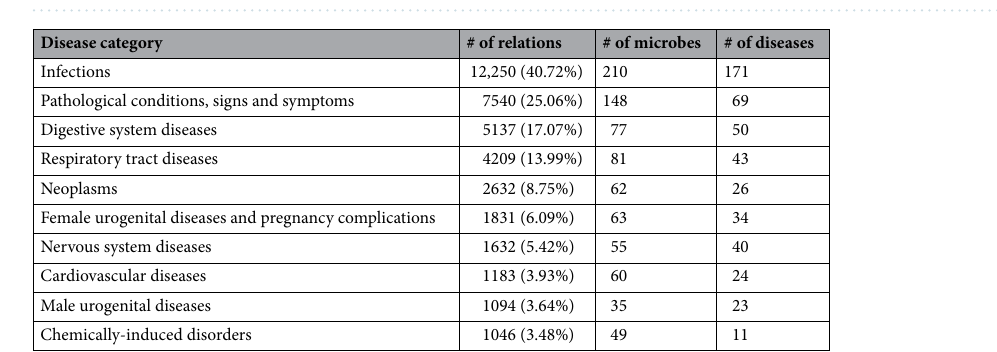
Figure 6. Distribution over the top-level MeSH disease categories and the bacterial families. The distribution of 30,085 relationships between 432 diseases and 319 bacteria is represented. The bacteria are shown in the top 20 bacterial families and others.